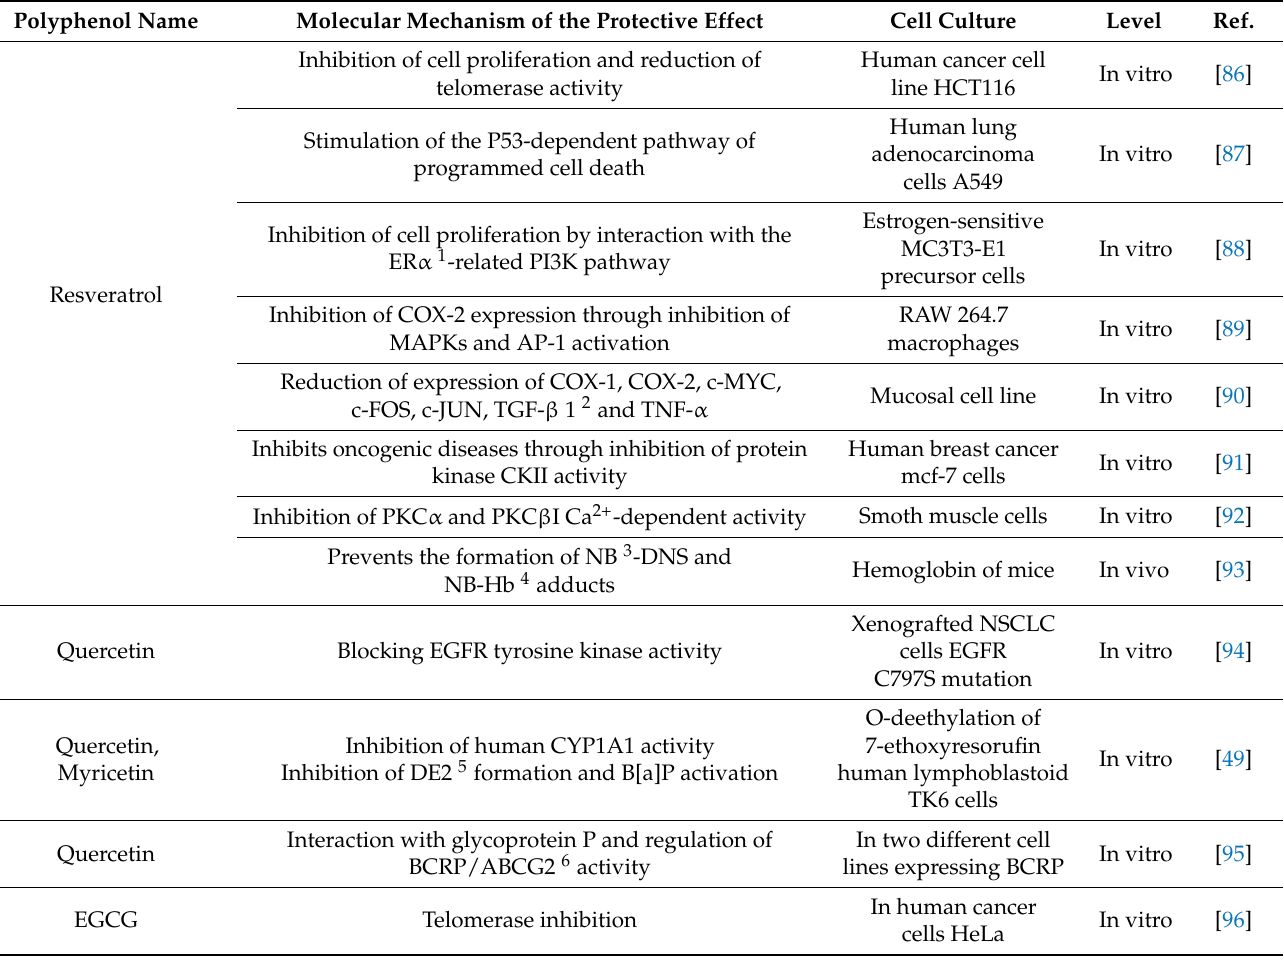
Table 9. Mutation-reducing/anti-cancer effects of the polyphenol content of grape marc (grape seeds and skins).